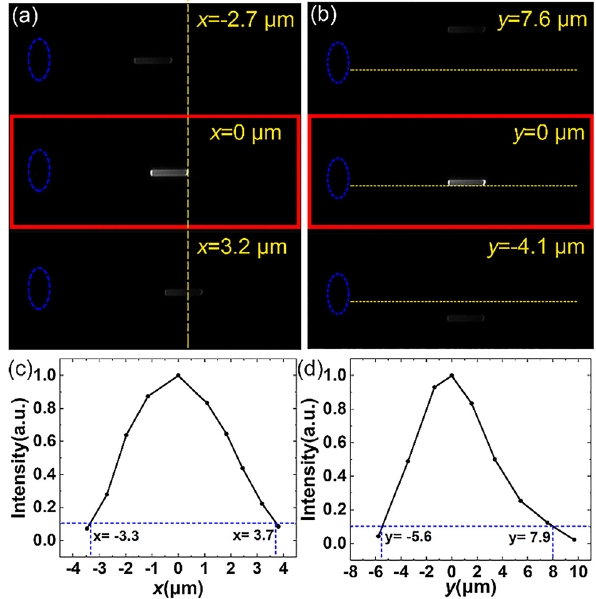
Figure 4: Verification of the IPWP method. (a) Optical images of a perovskite microplate at x = − 2.7 μ m (top panel), x = 0 μ m (middle panel), and x = 3.2 μ m (bottom panel), respectively. The yellow dashed line is the reference line for the sample position. The blue dashed ellipses indicate the pump spots. (b) Optical images of the perovskite microplate at y = 7.6 μ m (top panel), y = 0 μ m (middle panel) and y = − 4.1 μ m (bottom panel), respectively. The yellow dashed line is the reference line for the sample position. The blue dashed ellipses indicate the pump spots. Emission intensities of the perovskite microplate at different positions when the sample is moved along the x -axis direction (c) and y -axis direction (d). The blue horizontal dashed lines denote the emission intensity, which is 0.1 times the intensity at origin